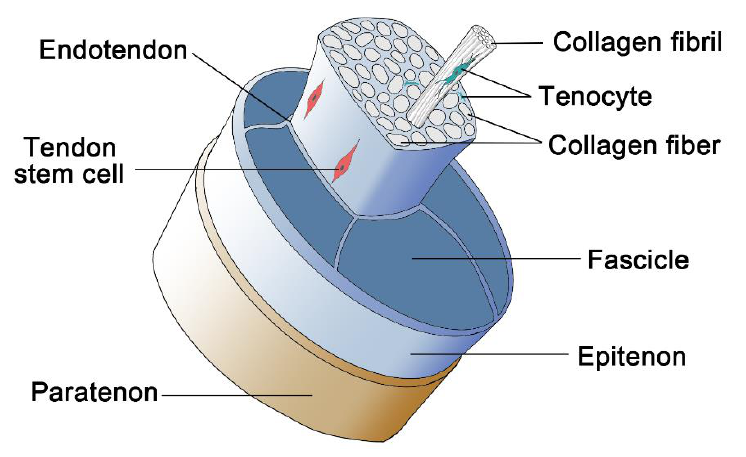
Figure 4. The hierarchical structure of tendon and ligament.